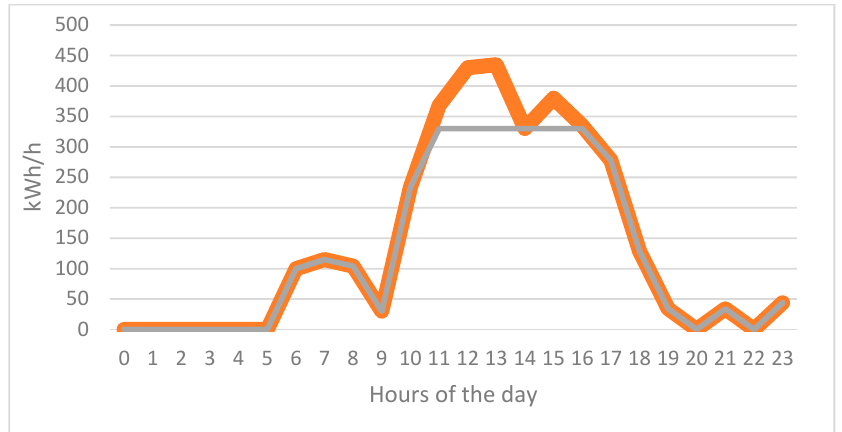
Figure 4. Average daily load profile at the INSPIRIA charging station (orange line) versus a daily profile where battery storage has been utilized (grey line). The storage-enhanced load reduction is represented by the difference between the orange and the grey line.